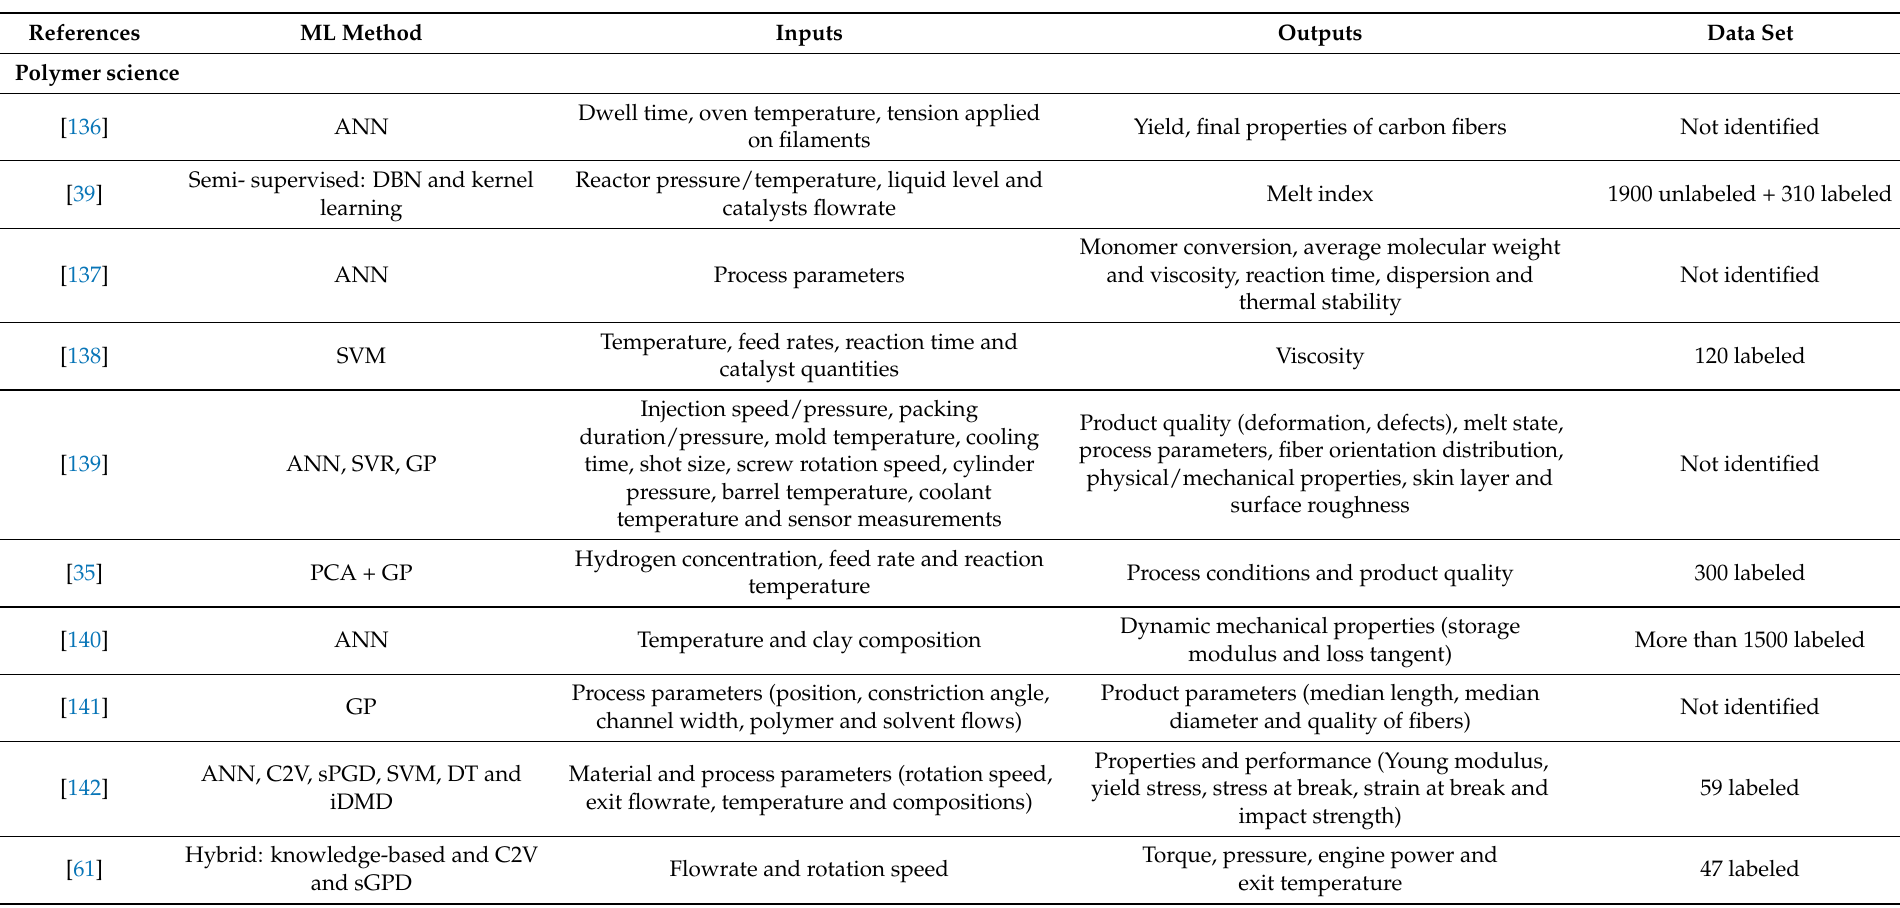
Table 7. Applications of ML in process–properties modeling. Acronyms: ANN: artificial neural network, C2V: code2vect, CFD: computational fluid dynamics, DBN: deep belief network, DoE: design of experiments, DT: decision tree, GP: Gaussian process, iDMD: inspired by dynamic model decomposition, LMNNR: large margin nearest neighbor for regression, MR: multivariate regression, PCA: principal component analysis, RF: random forest, sPGD: sparse proper generalized decomposition, and SVM/SVR: support vector